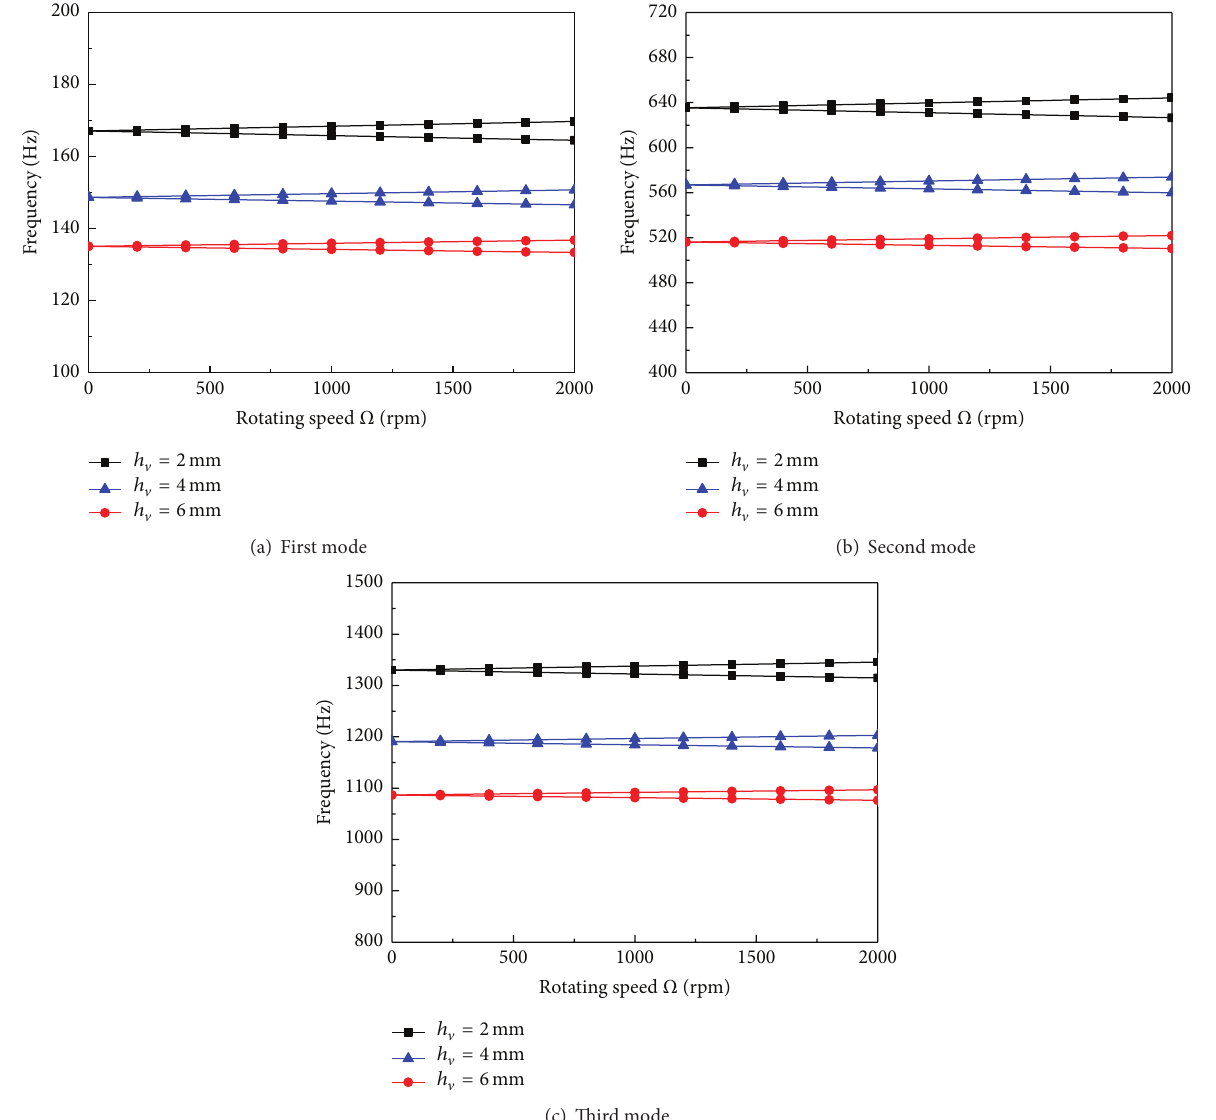
𝐿 𝜉 𝜂 󸀠󸀠 𝑑𝑥 − 𝑘 ∫ 𝑖 31 𝑗 0 ] , 𝑖,𝑗 𝐿 𝜂 󸀠 𝜉 󸀠 𝑑𝑥 − 𝑘 ∫ 13 𝑖 𝑗 0 𝐿 𝜂 󸀠 𝜉 󸀠 𝑑𝑥 − 𝑘 ∫ 12 𝑖 𝑗 0